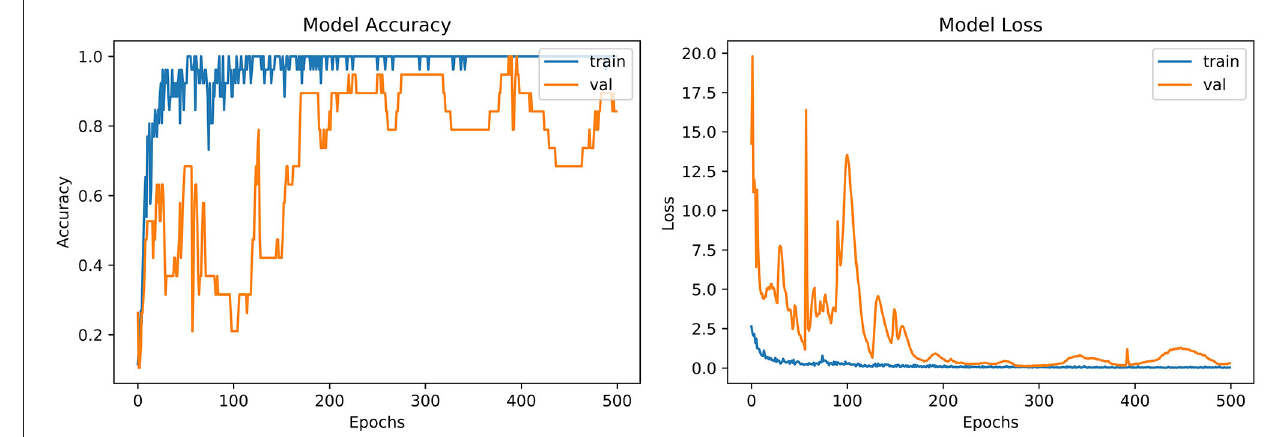
FIGURE 6 | Model accuracy and model loss for LeNet-5.